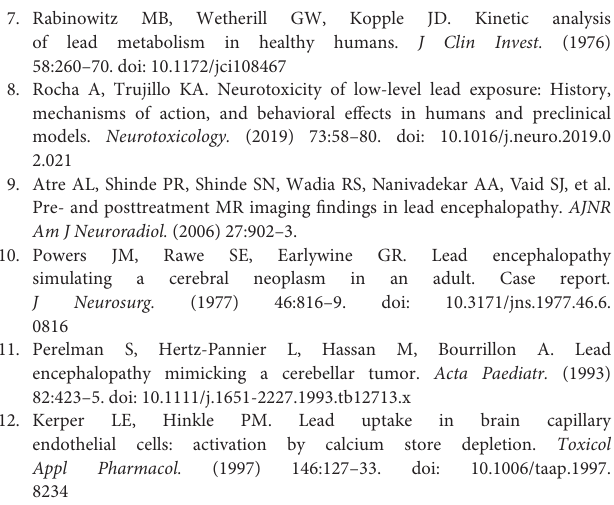
Supplementary Figure 1 | Initial abdominal X-ray demonstrating copious radiopaque material. Supplementary Figure 2 | MRI demonstrating non-enhancing, diffusion restricting temporal